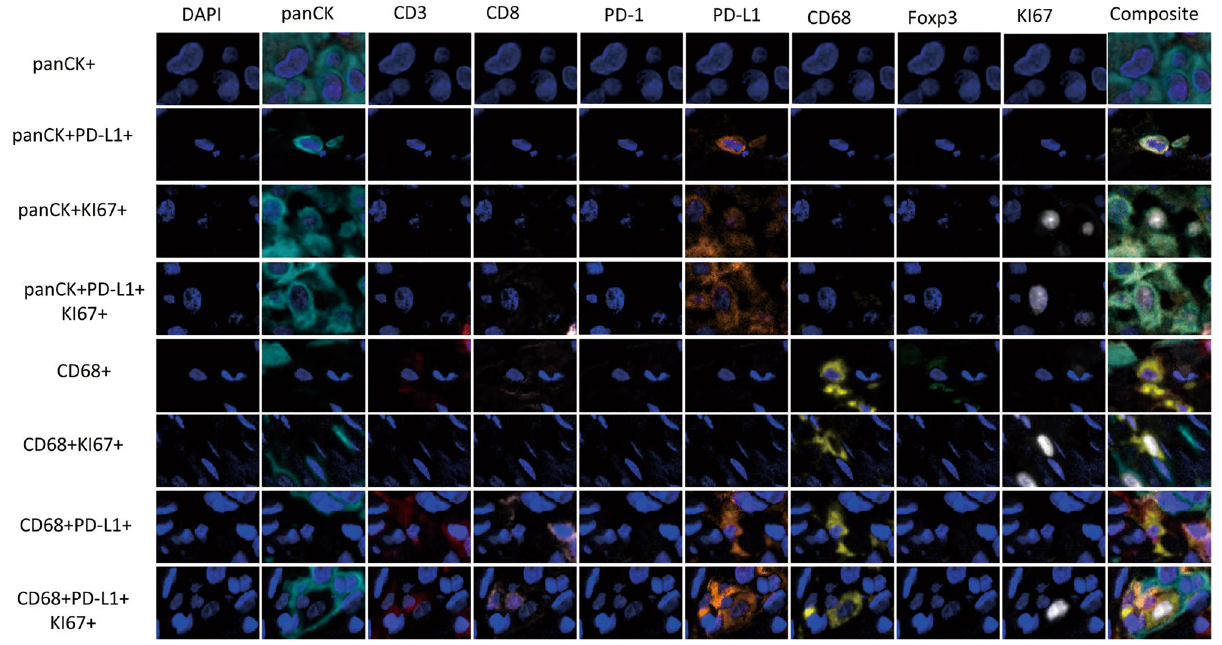
Figure 2. Microphotographs of representative examples of co-localization of malignant cells (panCK +) and macrophages (CD68 +) cells populations observed with the multiplex immunofluorescence panel in the malignant pleural mesothelioma cohort. The images were generated using Vectra/Polaris 3.0.3 scanner system and InForm 2.4.8 image analysis software (Akoya